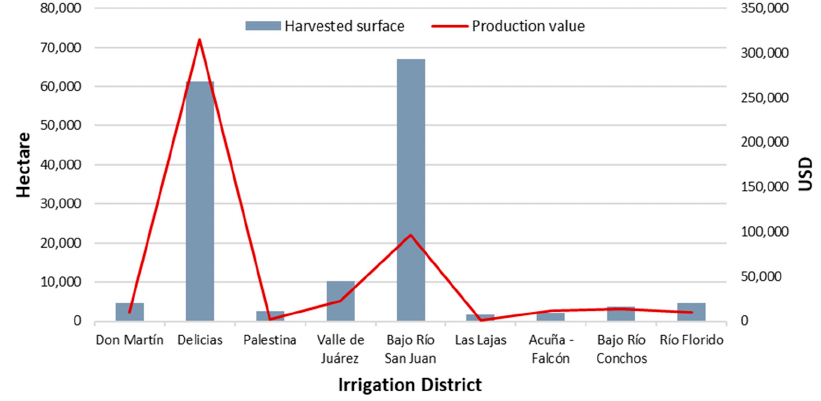
Figure 1. Location of the study area.